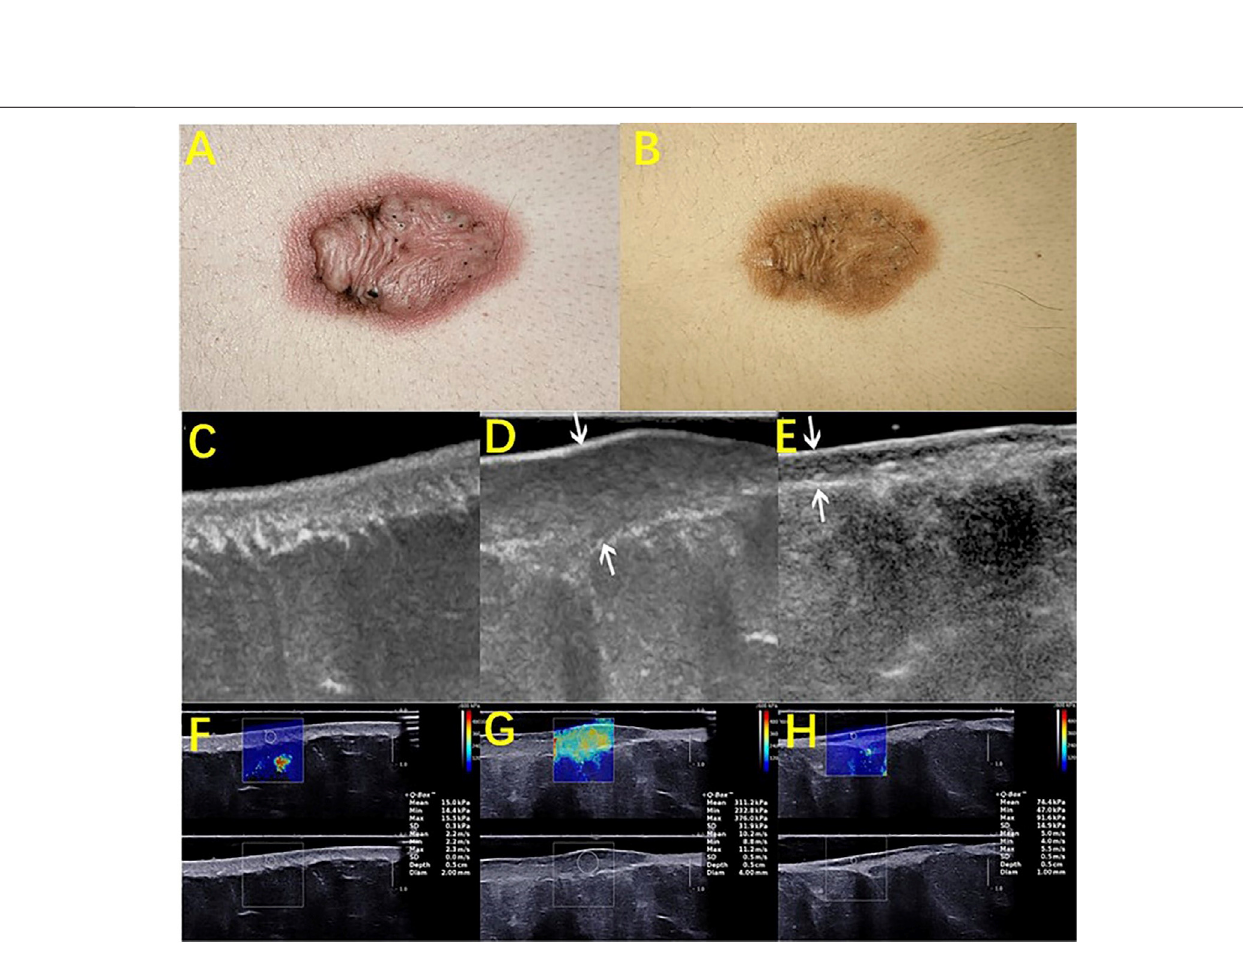
Frontiers in Physiology |